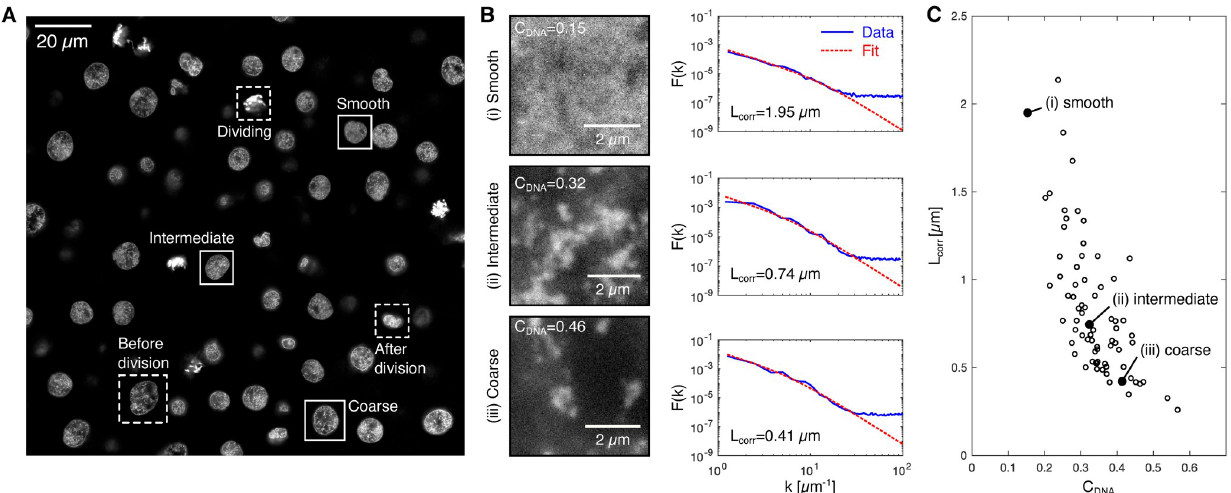
Fig 2. Cell nuclei in the zebrafish embryo display a continuum of euchromatin organization patterns. A) Overview of different chromatin organization patterns in nuclei of a sphere stage zebrafish embryo. Examples of different euchromatin organization patterns in interphase nuclei indicated by solid boxes. Examples of nuclei before, during, and after cell division indicated by dashed boxes—nuclei in these cell cycle stages were removed based on visual assessment. Excitation laser 599 nm, detection window 609 to 740 nm, detection gated to within 1.5 to 9 ns after the excitation pulse. B) Representative XY views of image stacks from within nuclei in the smooth, the intermediate, and the coarse euchromatin state. Also shown are image contrast values ( C image-based structure factor curves ( F ( k ), see Materials and methods), and the fitted F ( k ) function used to obtain the correlation length ( L corr ). C) Correlation length vs. image contrast plotted for 78 nuclei, image data obtained from four different embryos.